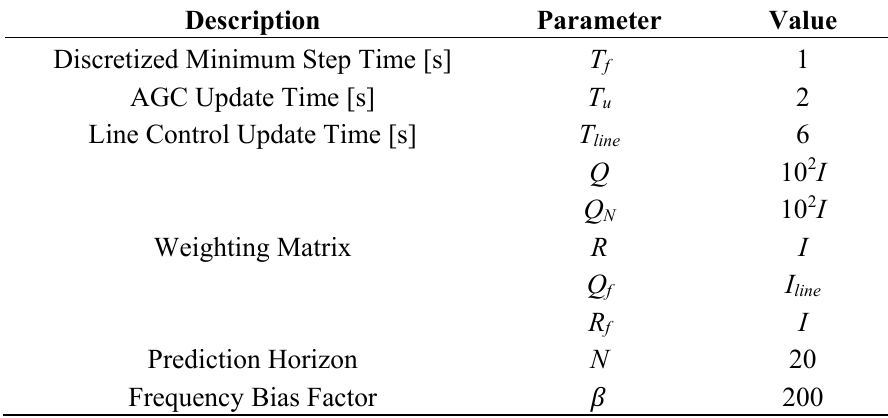
Figure 4. Centralized MPC-based AGC: ( A ) Without Line Flow Control (Original Case) ( B ) With Line Flow Control (Proposed). Table 3. Data and parameters for centralized MPC-based